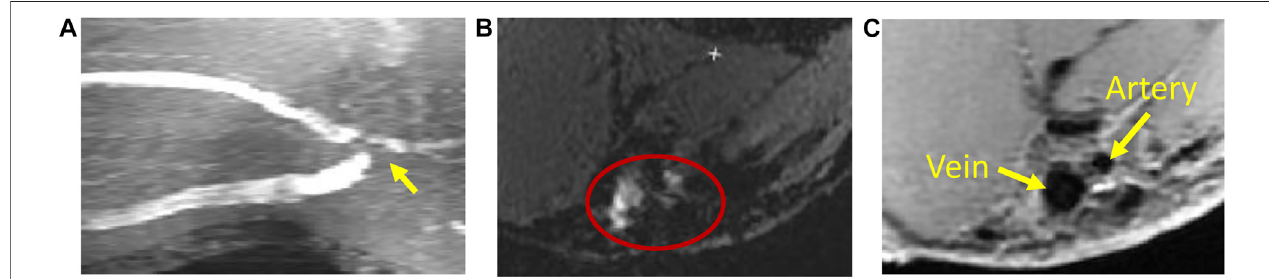
FIGURE2| Magneticresonanceimagingofanarteriovenous fi stula. (A) Maximalintensityprojectionofwhite-bloodtime-of- fl ight(TOF)images.Attheanastomosis (the gray region pointed by a yellow arrow), the signal isvoid due to complex fl ow. (B) An example ofthe TOF slice close to the anastomosis (enclosed by the red ellipse) where the lumen is not clearly de fi ned. (C) The black-blood image shows the lumen of the fi stula vein and artery clearly (the black regions pointed by yellow